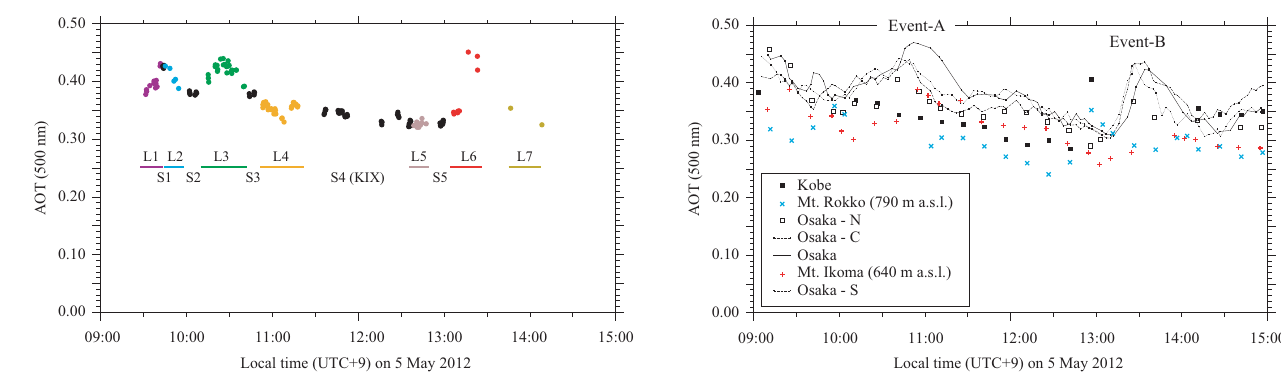
Figure 7. AOT (500nm) measurements observed by DRAGON- Osaka sites on 5 May 2012.